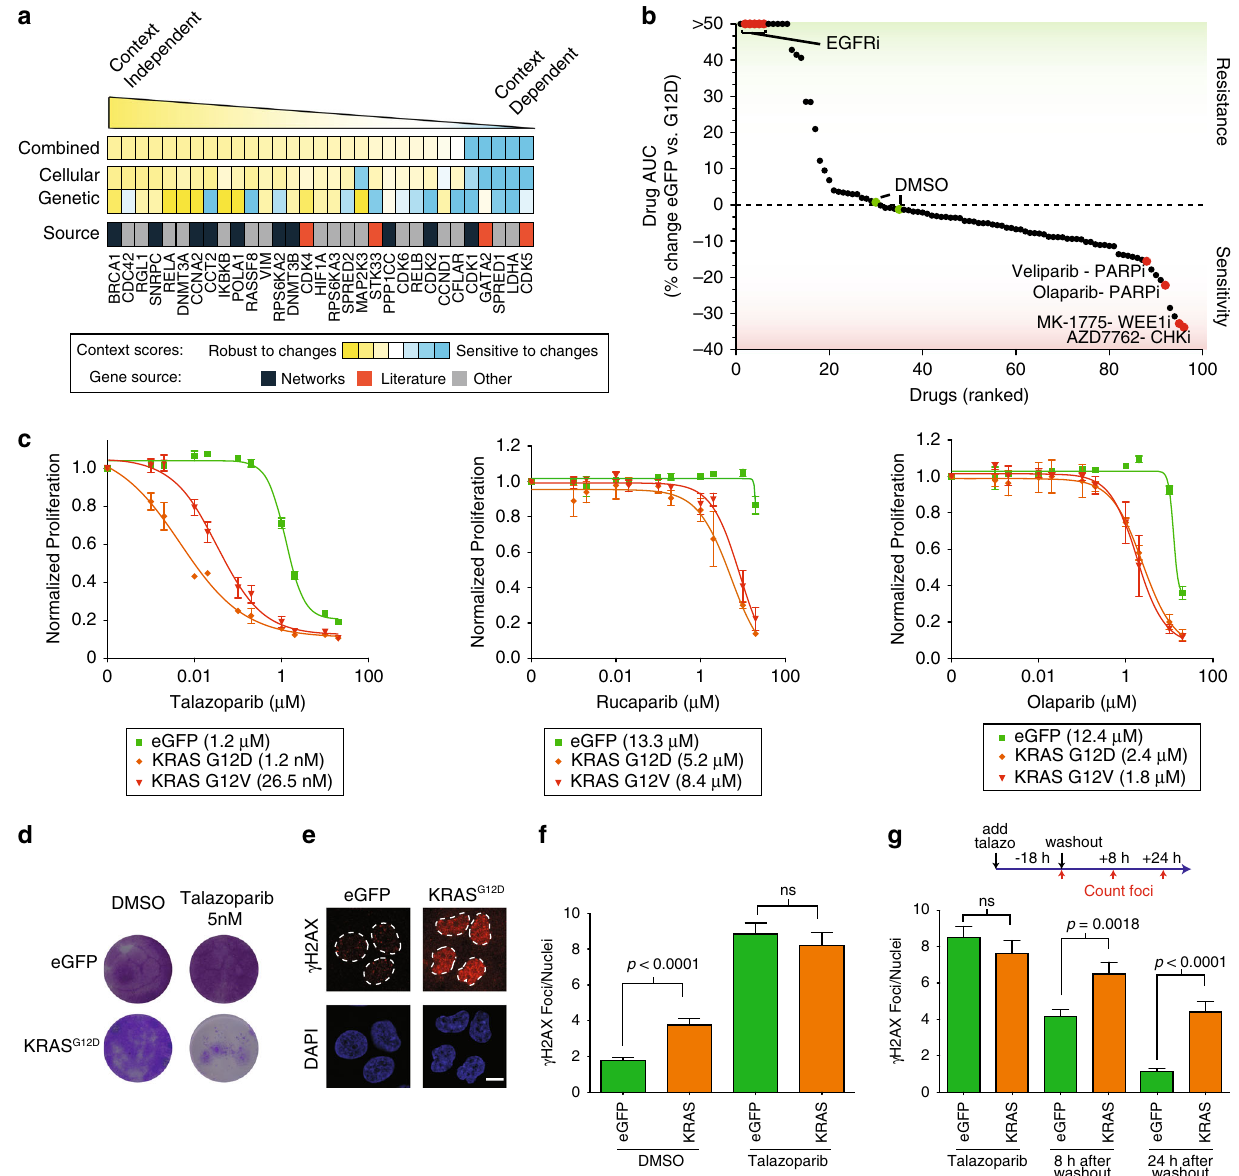
Fig. 6 PARP inhibitors are more effective in oncogenic KRAS-expressing cells. a Ranking of candidate KRAS synthetic lethal genes based on integration of genetic and cellular perturbation screens. Genes were selected for analysis based on evidence of synthetic lethality in MCF10A KRAS cells grown in minimal media. The conceptual source of each gene is listed. b Drug screen of 91 clinically relevant compounds ranked by sensitivity based on difference in the drug area under the curve (AUC) between eGFP cells grown in full media and KRAS G12D cells grown in minimal media. Dimethyl sulfoxide (DMSO) and epidermal growth factor receptor (EGFR) inhibitors indicated as controls for no effect and KRAS induced drug resistance, respectively. n = 4 biologically independent samples from each of 3 drug concentrations. c Relative proliferation of control eGFP, KRAS G12D or G12V expressing MCF10A lines after treatment with PARP inhibitors talazoparib, rucaparib or olaparib for 72 h. IC 50 values are shown. n = 4 biologically independent samples. d Long-term clonogenic growth of MCF10A KRAS G12D and eGFP cells treated with DMSO or talazoparib for two weeks. Experiment was repeated twice with similar results. e γ H2AX immuno fl uorescence in eGFP or G12D expressing cells, red. Nuclei outlines in dotted lines based on DAPI staining. Scale bar = 10um. Experiment was repeated twice with similar results. f Quanti fi cation of γ H2AX foci in the indicated cell lines treated with DMSO or with 500 nM of talazoparib for 18 h. n > 90 biologically independent cells analyzed from 3 independent experiments. g Treatment of the indicated cells with 500 nM talazoparib for 18 h, then washed out. γ H2AX foci quanti fi ed before, 8 and 24 h after washout. n > 104 biologically independent cells analyzed from 3 independent experiments. p values using two-tailed Student ’ s t test. Data are presented as mean values ± s.d. except f and g which are s.e.m. Not signi fi cant,